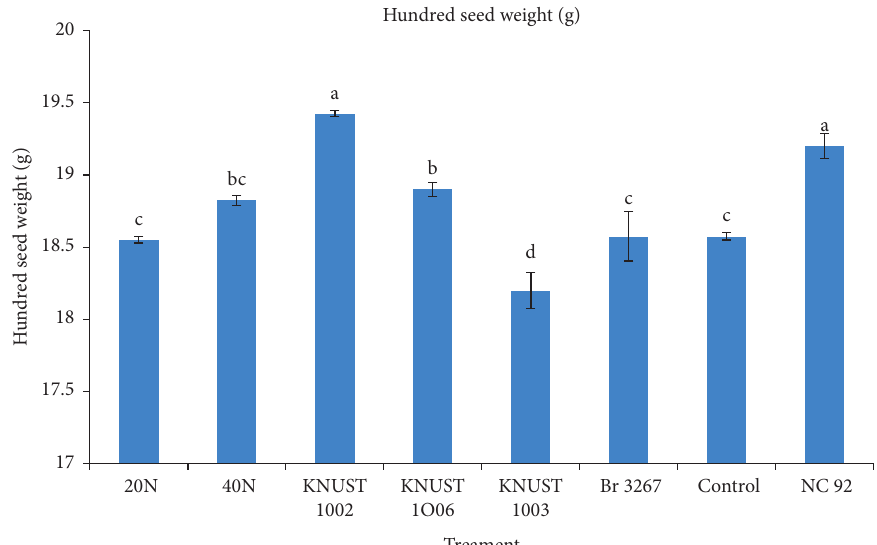
Figure 4: Effects of rhizobial inoculation and N fertilizer application on hundred seed weigh of cowpea. Bars with different letters denote significance at P < 0 . 05. Error bars denote the standard error of means. Means comparison was conducted using least significant